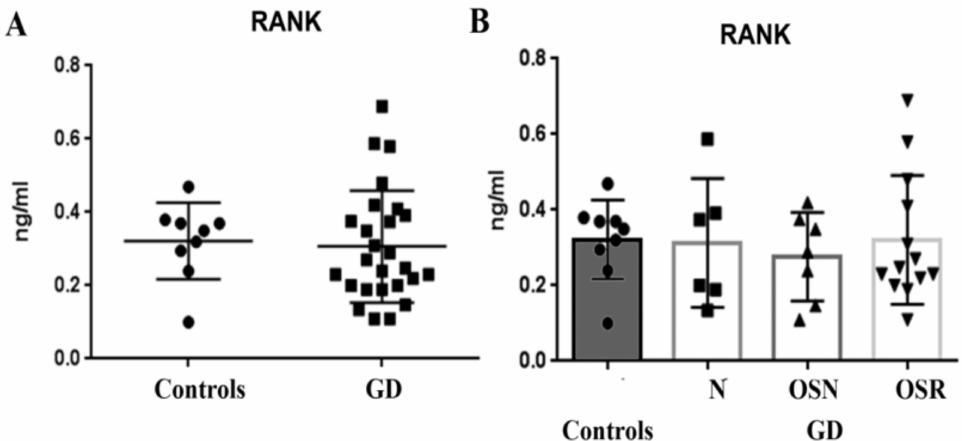
Figure 3. Circulating RANK levels in patients with GD. ( A ) RANK levels, control vs. GD group (mean 0.30 ± 0.02, n = 30). ( B ) RANK concentrations in control (mean 0.32 ± 0.03, n = 10) and GD groups N, OSN, and OSR. Data are means ± SEM. Measurements are in ng/mL. 3.4. Elevated OPG Does Not Correlate with OSN or OSR in GD